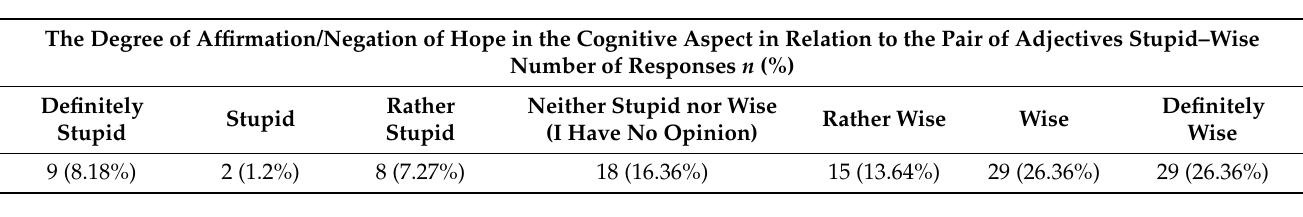
Table 5. The degree of affirmation/negation of hope in the cognitive aspect in relation to the pair of adjectives stupid–wise expressed by men in the terminal stage of cancer ( n = 110).